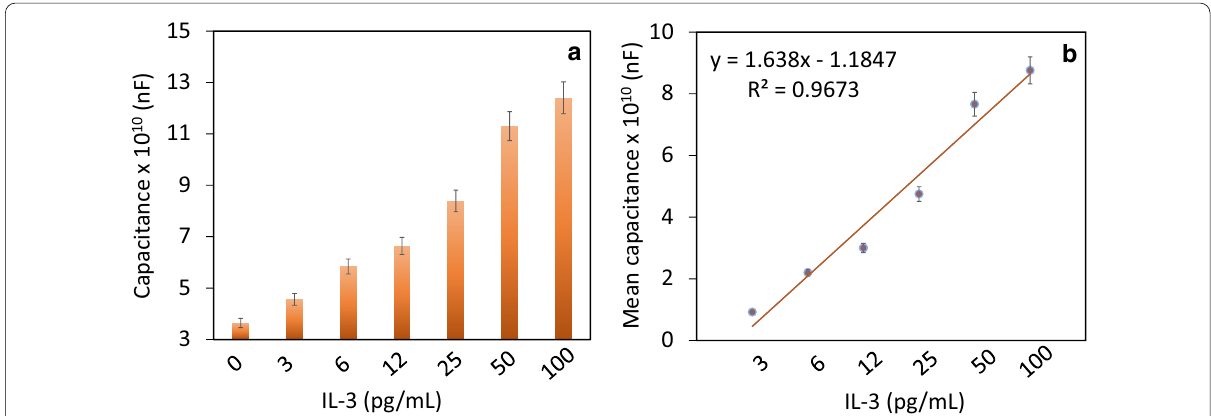
Fig. 5 a Capacitance value for each IL-3 concentration. Increasing the IL-3 concentration produced a gradual increase in the capacitance value. b Difference in the capacitance value for each IL-3 concentration. The values were plotted in an Excel sheet, and the detection limit of IL-3 was calculated as 3 pg/mL. The values were averaged using three readings as triplicates